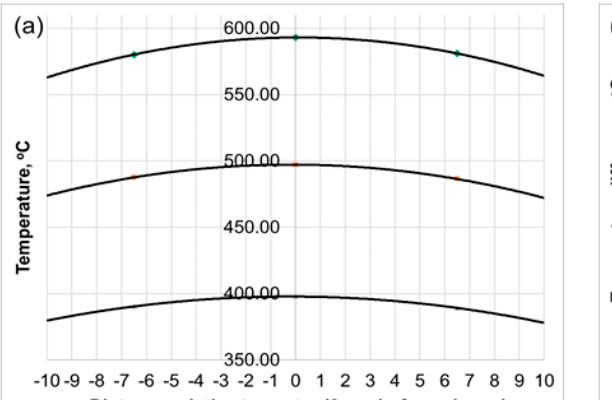
Figure 2. Temperature distribution along the longitudinal and transversal directions of a specimen: ( a ) measured tem- perature distribution along the longitudinal direction, ( b ) comparison of temperature difference (Tmax-Tmin) at ± 3 mm distance relative to the center along the longitudinal direction, and ( c ) measured temperature distribution along the transversal. (b) Figure 3. Temperature evolution at the center of the specimen during a tensile test: ( a ) performed at 535 °C and ( b ) an enlarged view in the circle of ( a ).